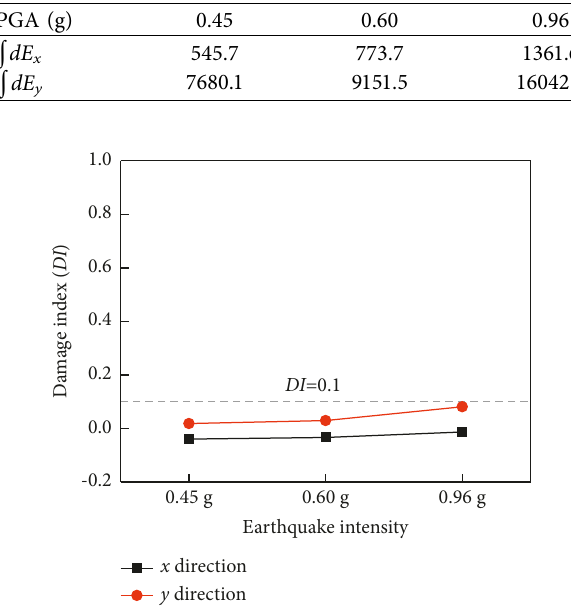
Figure 12: Variation of specimen damage indices with earthquake